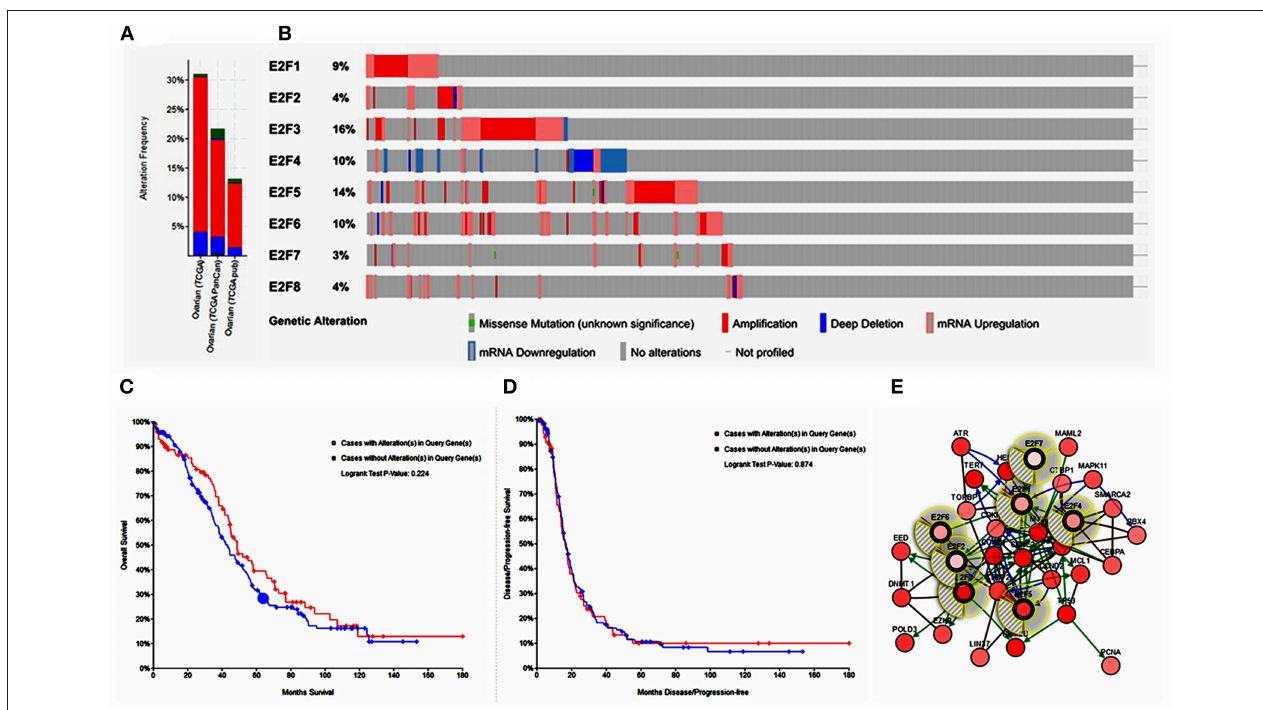
FIGURE 5 | Alteration frequency of E2F family members and neighbor gene network in OC (cBioPortal). (A) Summary of alterations in E2F family members. (B) OncoPrint visual summary of alteration on a query of E2F family members. (C) Kaplan–Meier plots comparing OS in cases with/without E2F family member gene alterations. (D) Kaplan–Meier plots comparing disease-free survival (DFS) in cases with/without E2F family member alterations. (E) Gene–gene interaction network among E2F family members and 50 most frequently altered neighboring